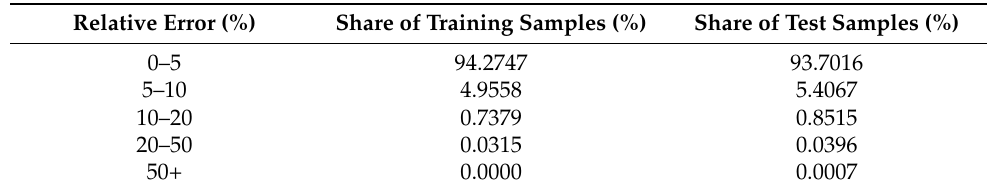
Table 7. Function loss values for the training and test datasets for a 4-layer model with 280 nodes per layer.